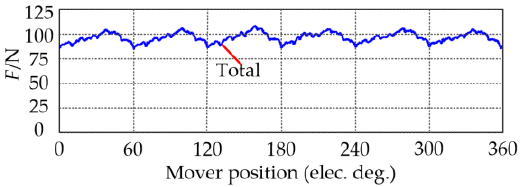
Figure 19. The measured waveform of the total electromagnetic thrust force.